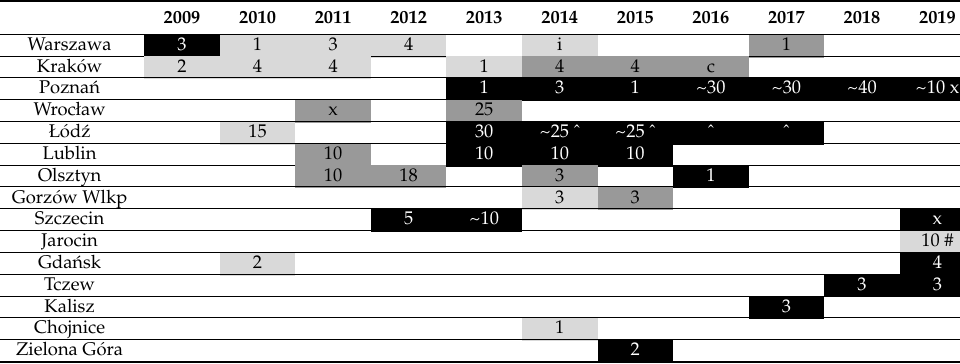
Table 2. City council involvement (black—city council financial support; dark grey—cc agreement / permission; light grey—independent—no support) and the amount of parking spaces taken over during PD (numbers). Additional key: ~—estimated number; x—event on a street closed for tra ffi c; #—event at a closed up private parking lot; ˆ—event at a closed up public parking lot; c—Cargo Park(ing) Day—presentation of cargo bikes without parking spots taken over; i—event inspired by Park(ing) Day but not on a parking spot.